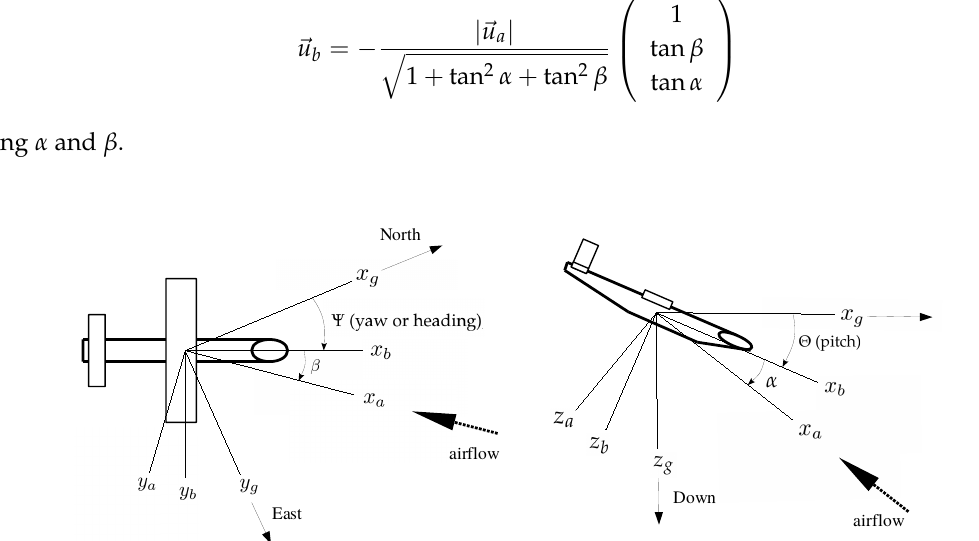
Figure 1. Top view ( left ) and side view ( right ) of the coordinate systems with the indices a , b , and g representing, the aerodynamic, body, and geodetic coordinate systems. Ψ is the yaw angle or true heading and Θ is the pitch angle of the UAV. The side-slip angle β and the angle of attack α are located between the aerodynamic and body-fixed coordinate